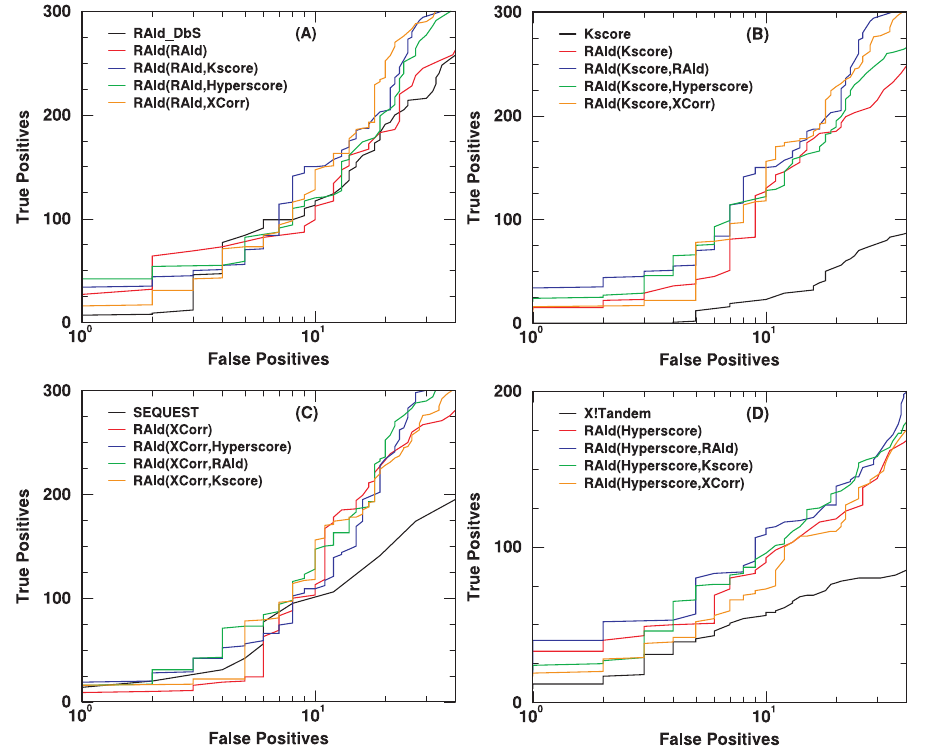
Figure 7. ROC curves for the centroid data (A1–A4 of the ISB data set [ 28 ] ) when considering only the best hit per spectrum. For each of the four scoring functions considered, a set of ROC curves is shown. These ROC curves include in the consideration only the best hit per spectrum from running the designated program associated with that scoring function, the best hit per spectrum from running RAId_aPS in the database search mode, and the best hit per spectrum from combining with each of the three other scoring functions. Panel (A) shows the results from RAId score, whose designated program is RAId_DbS. Panel (B) displays the results from K-score, whose designated program is X!Tandem. Panel (C) exhibits the results from XCorr, which is mostly employed by SEQUEST. Panel (D) presents the results from Hyperscore, whose designated program is also X!Tandem. Instead of using only XCorr (like RAId_aPS), SEQUEST first selects the top 500 candidates using SP score. As shown in panel (C), for centroid data there is advantage to filter candidates with the SP score. However, it is also seen that by combining XCorr with either RAId score or Hyperscore, equally good results can be attained without introducing the SP score heuristics.